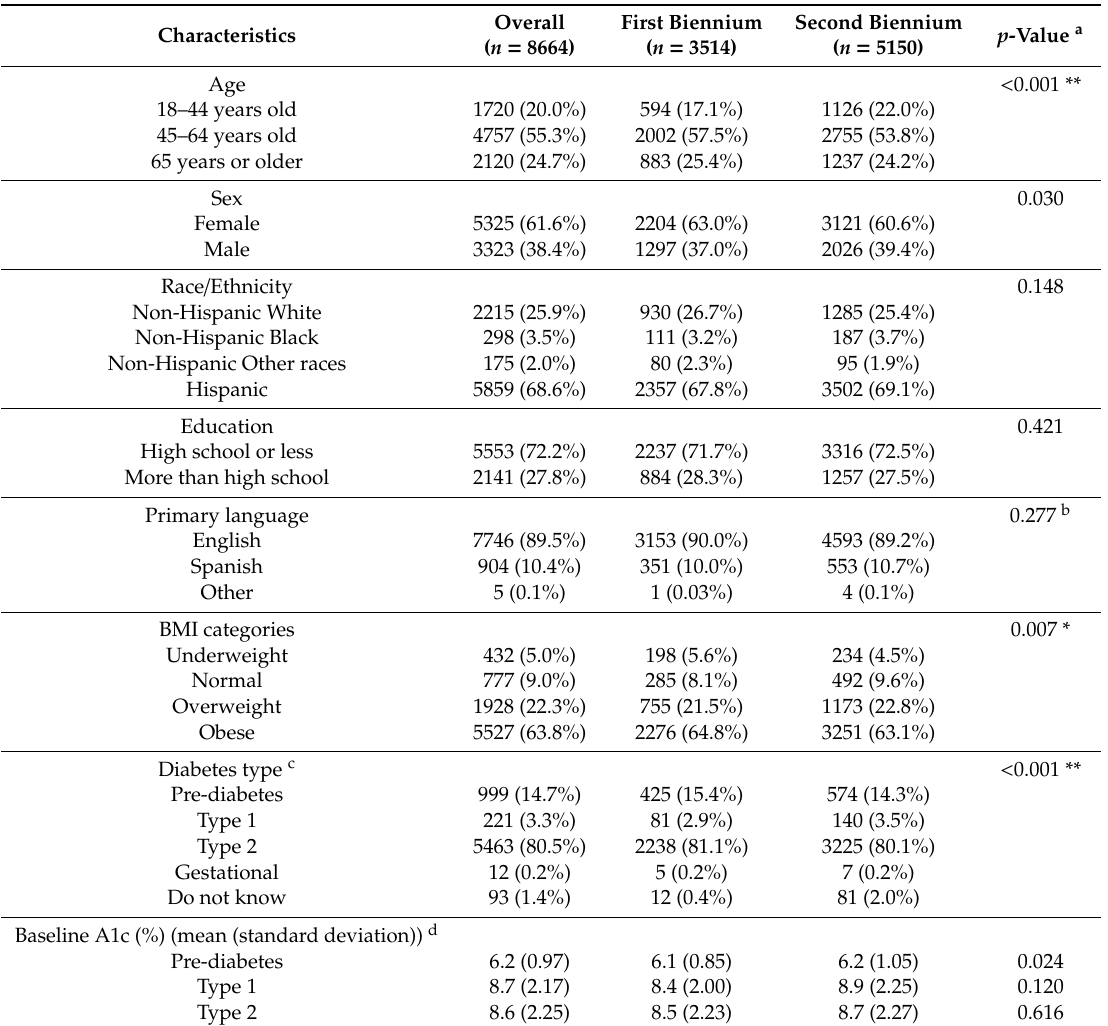
Table 1. Characteristics of program